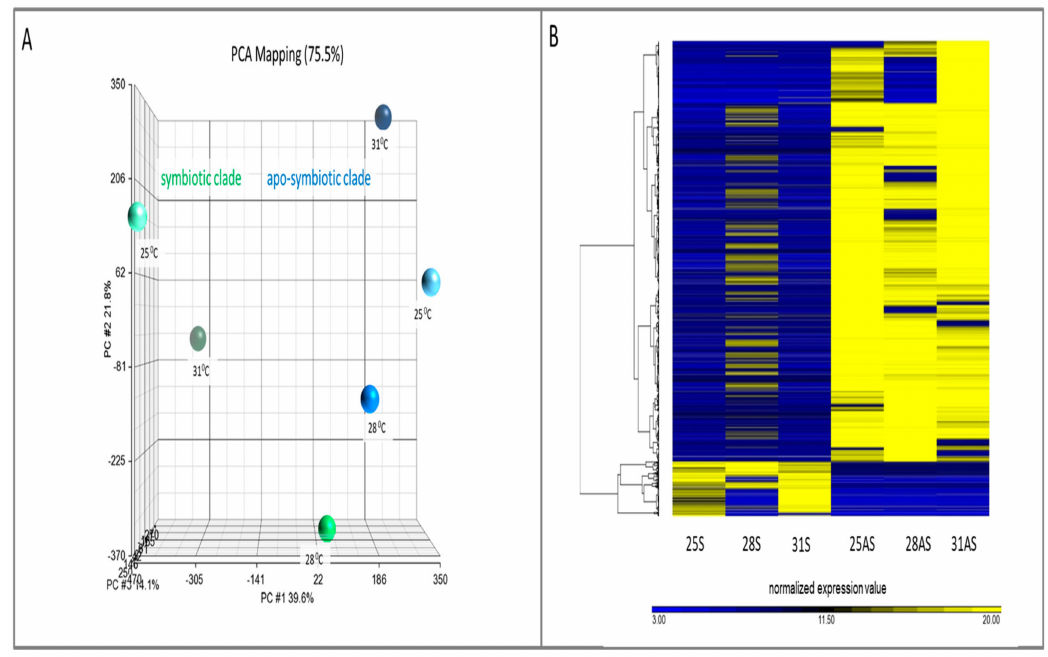
Figure 2. Clustering of symbiotic and apo-symbiotic samples. ( A ) Principle component analysis (PCA) of all the samples, capturing 75.5% of total variability. ( B ) Heat map of hierarchical clustering of all di ff erentially expressed genes. S: symbiotic; AS: apo-symbiotic; 25, 28, and 31: temperature treatment. Scale shows normalized expression values generated using Euclidean distance as a similarity measure and average